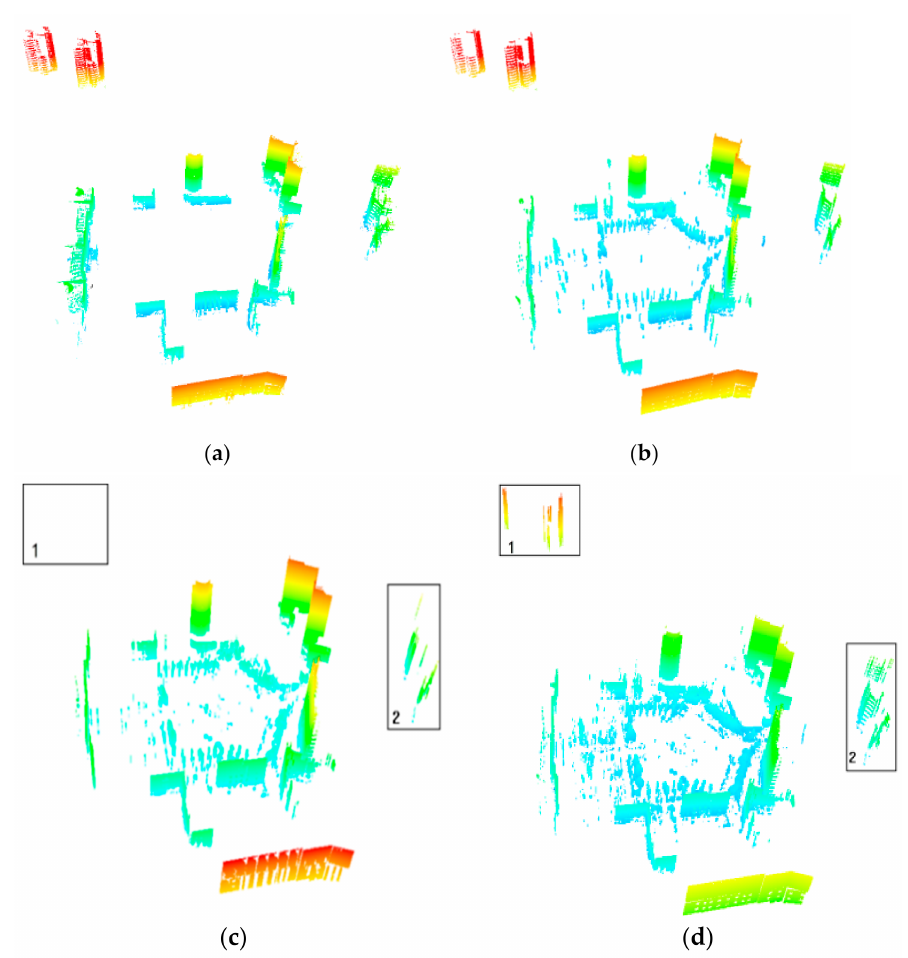
Figure 10. Comparison of the filtering results of our method and the original DoPP filtering. ( a ) shows the manually extracted building points; ( b ) the result of our method corresponding to the median F1 value among the 200 runs; ( c ) the result of the original DoPP filtering, with the highest F1 value among the 300 runs; and ( d ) the result of the original DoPP filtering with the empirical parameters based on the methods of [24,57]. Our method performs better when it comes to distinguishing long-range buildings points (boxes 1 and 2) from close-range crown